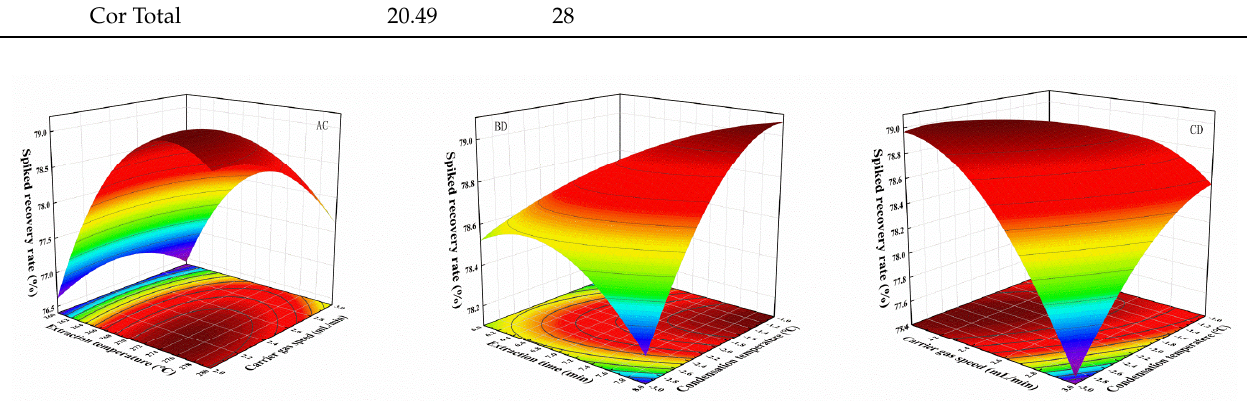
Figure 2. Effect of factors AC, BD, and CD interaction response